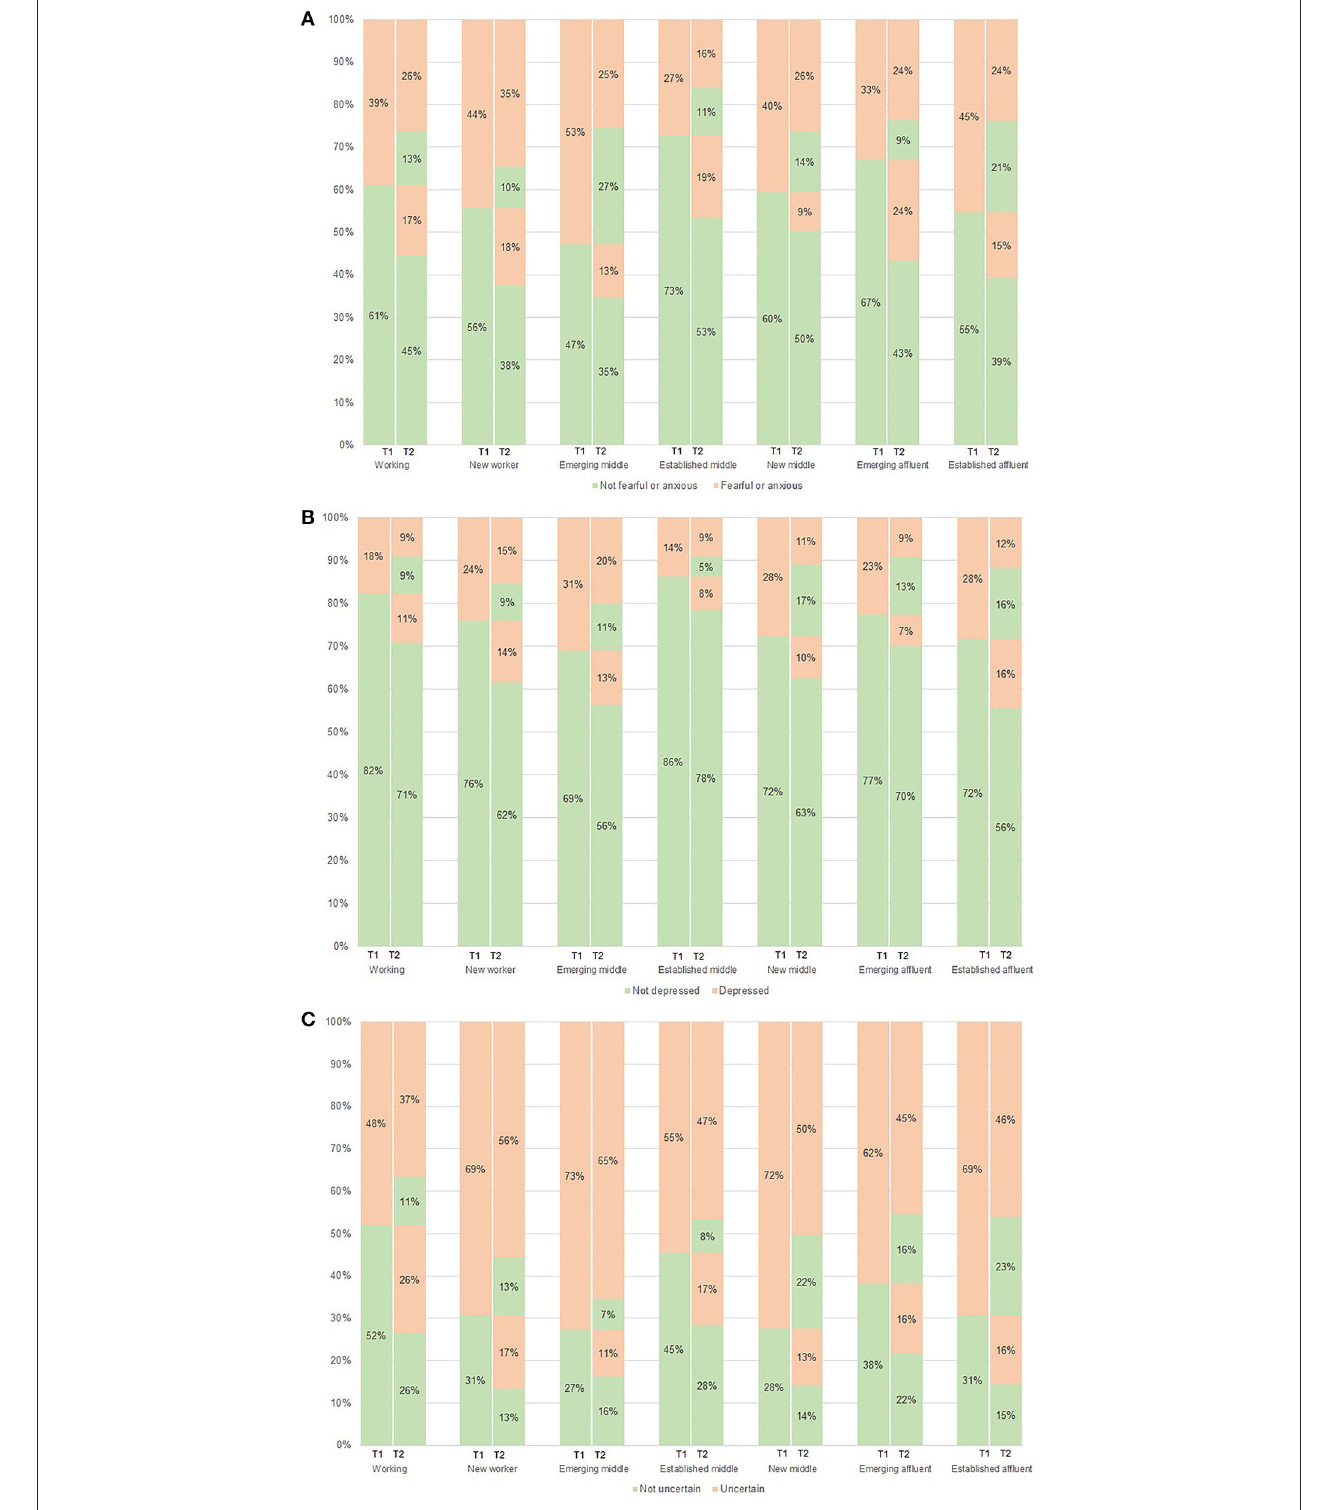
FIGURE 2 | Changes in negative affect between time point 1 and time point 2 during COVID-19 by social class. (A) Feeling fearful or anxious. (B) Feeling depression. (C) Feeling uncertainty.